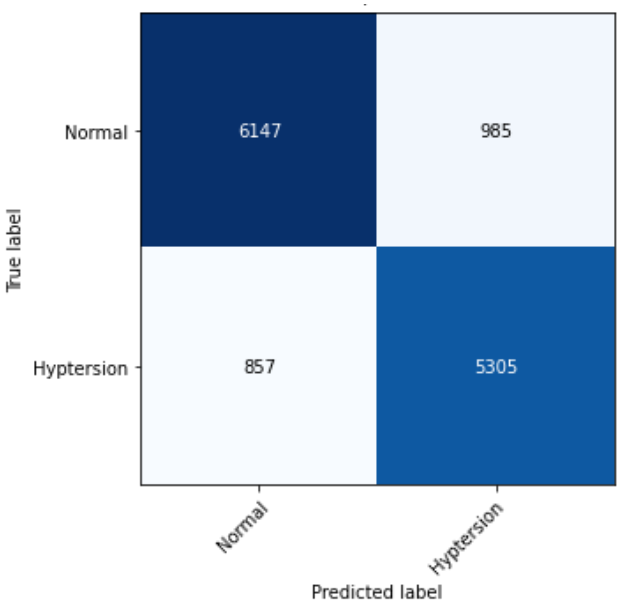
Figure 9. Confusion matrix obtained for the proposed model (with testing